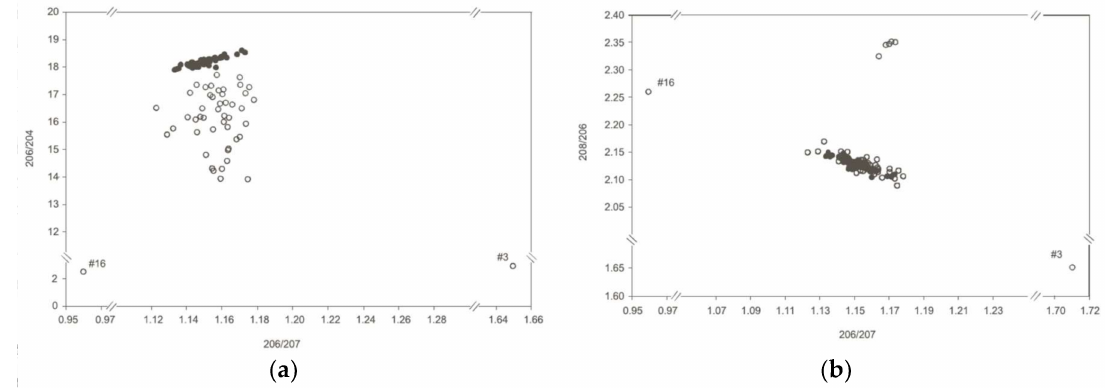
Figure 4. ( a ) 206 Pb/ 204 Pb versus 206 Pb/ 207 Pb plot of blood (open circles) from swans and ammunition pellets showing the large scatter of data possibly arising from analytical problems for the blood samples. ( b ). 208 Pb/ 206 Pb versus 206 Pb/ 207 Pb plot showing consistency in blood and pellet data for most samples. (Data from